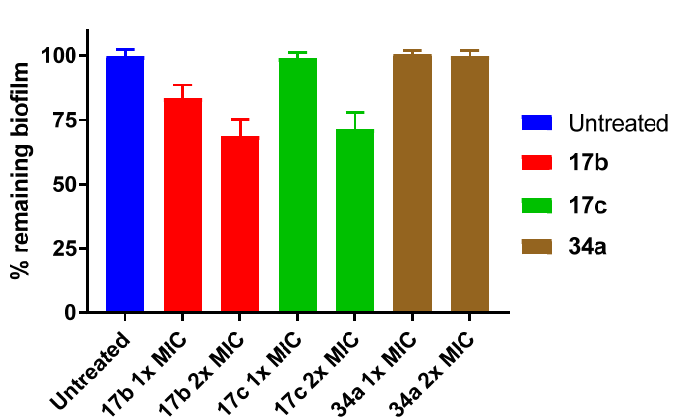
Figure 4. Percentage remaining E. coli biofilms following 24 h treatment with peptidomimetics 17b, 17c and 34a at 1 × and 2 × MIC. Error bars represent the standard error of triplicates ( n = 3).